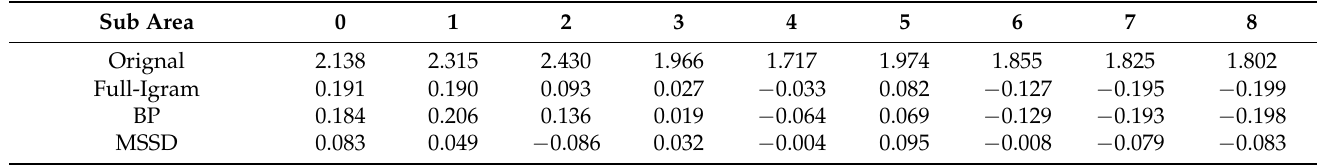
Table 4. Correlation coefficients of 9 sub-regions after